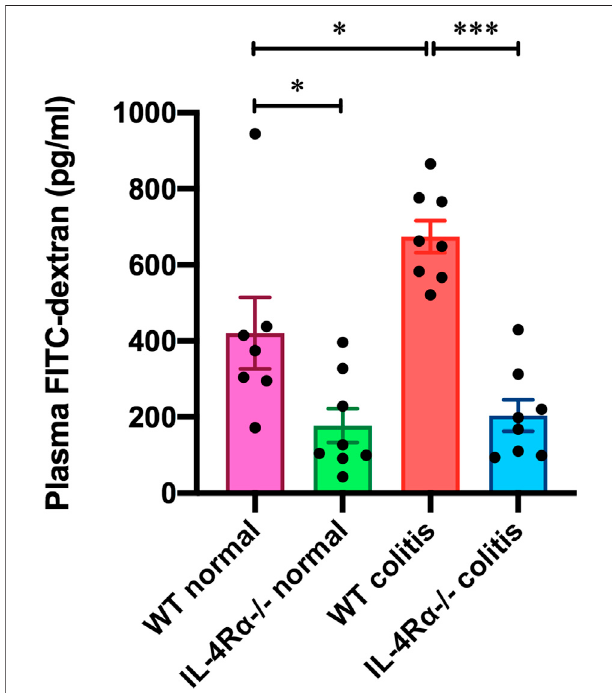
FIGURE6| IL-4R α de fi ciencyenhancesintestinalbarrierfunction invivo . The concentration of FITC-dextran in the plasma of WT and IL-4R α -/- mice is shown.Plasma sampleswere collected from WTand IL-4R α -/- mice on day 0 (normal) or day 7 (colitis) after initiation of DSS treatment. The data are presentedasthemean ± SEMvalues forseven toeight mice.* p < 0.05; *** p < 0.001.